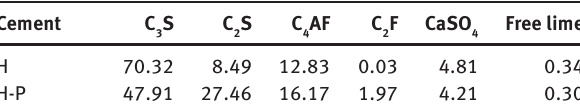
Table 1: Main compound compositions of Class H and Class H-P cement.